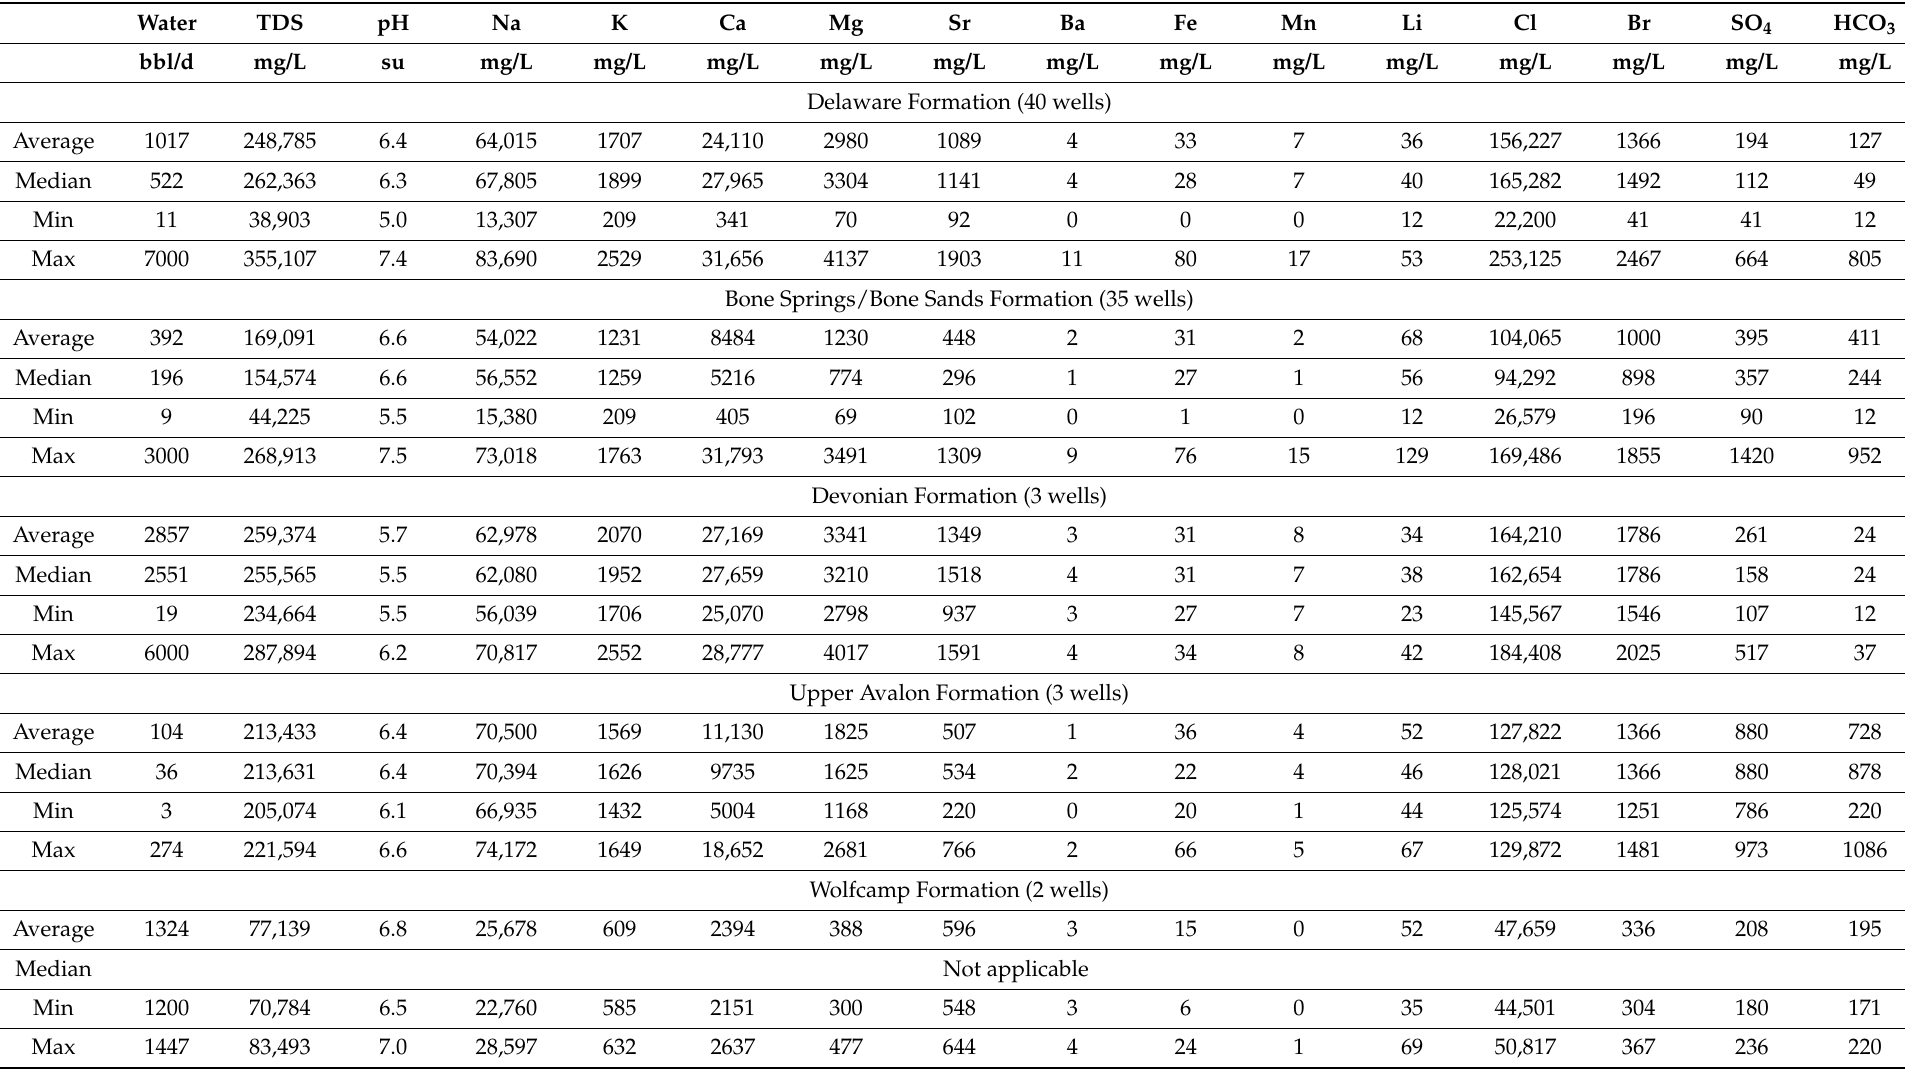
Table 1. Summary of produced water quality used in this study (from XTO operations in